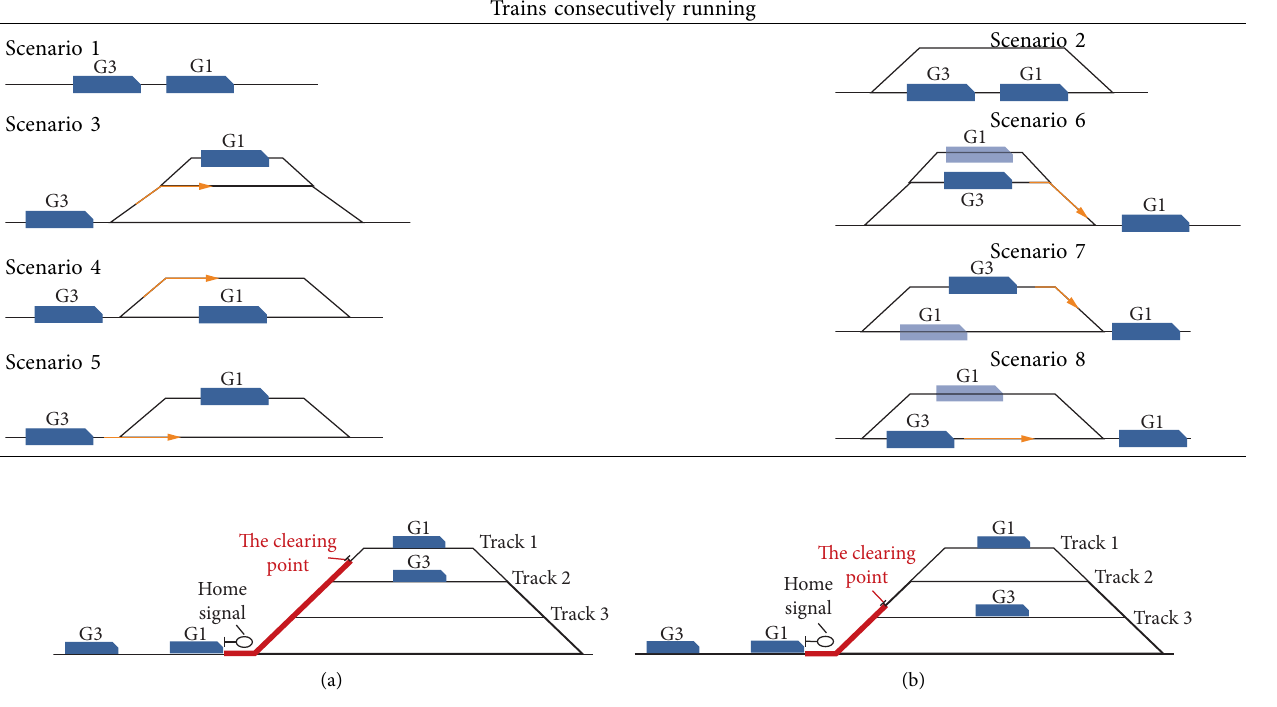
Figure 3: Positions of the clearing points corresponding to track combinations 1 and 2. (a) Track combination 1. (b) Track combination 2.